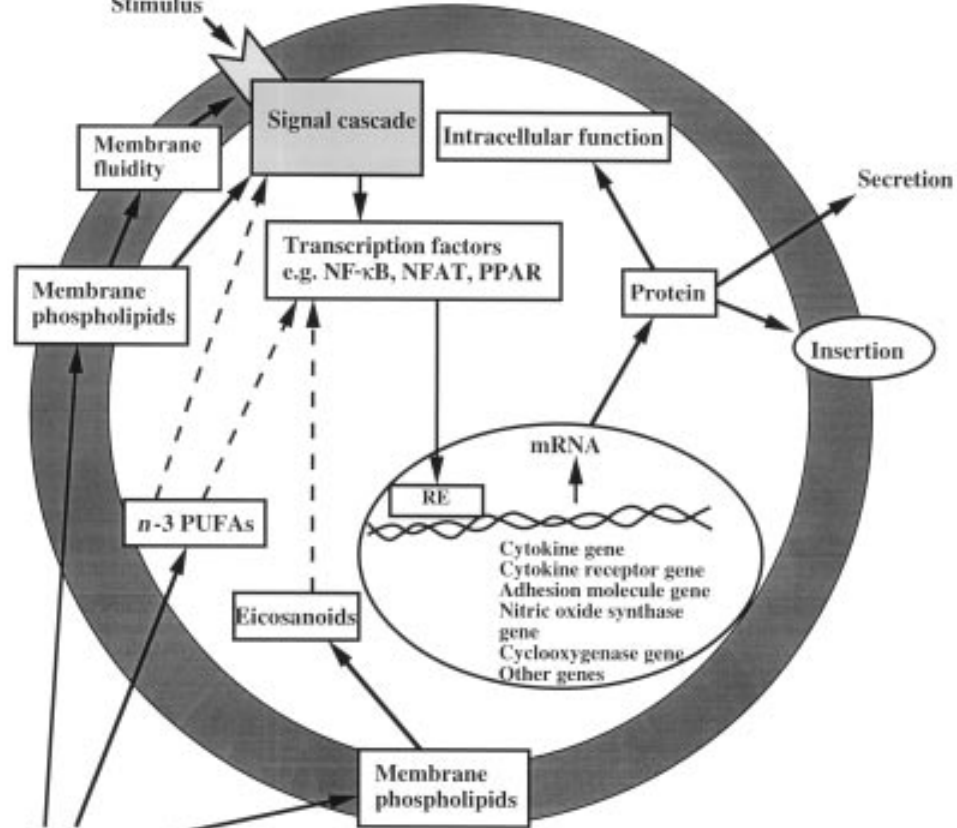
Figure 3 - Schematic representa- tion of the mechanisms by which n-3 PUFAs might influ- ence immune cell